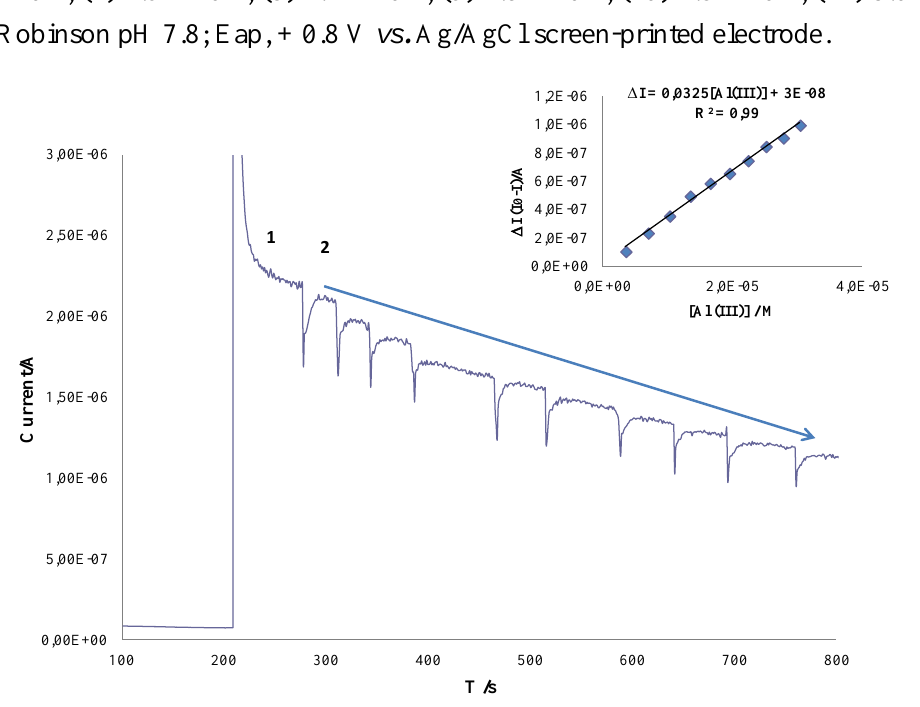
Figure 3. Typical amperometric recording for an acethylthiocholine iodide concentration (1) 2.4 × 10 −4 M and consecutive additions of aliquots of Al(III) solution into the cell to give an overall concentration of: (2) 3.6 × 10 −6 , (3) 7.0 × 10 −6 , (4) 1.0 × 10 −5 , (5) 1.3 × 10 −5 , (6) 1.6 × 10 −5 , (7) 1.9 × 10 −5 , (8) 2.2 × 10 −5 , (9) 2.5 × 10 −5 , (10) 2.8 × 10 −5 , (11) 3.0 × 10 −5